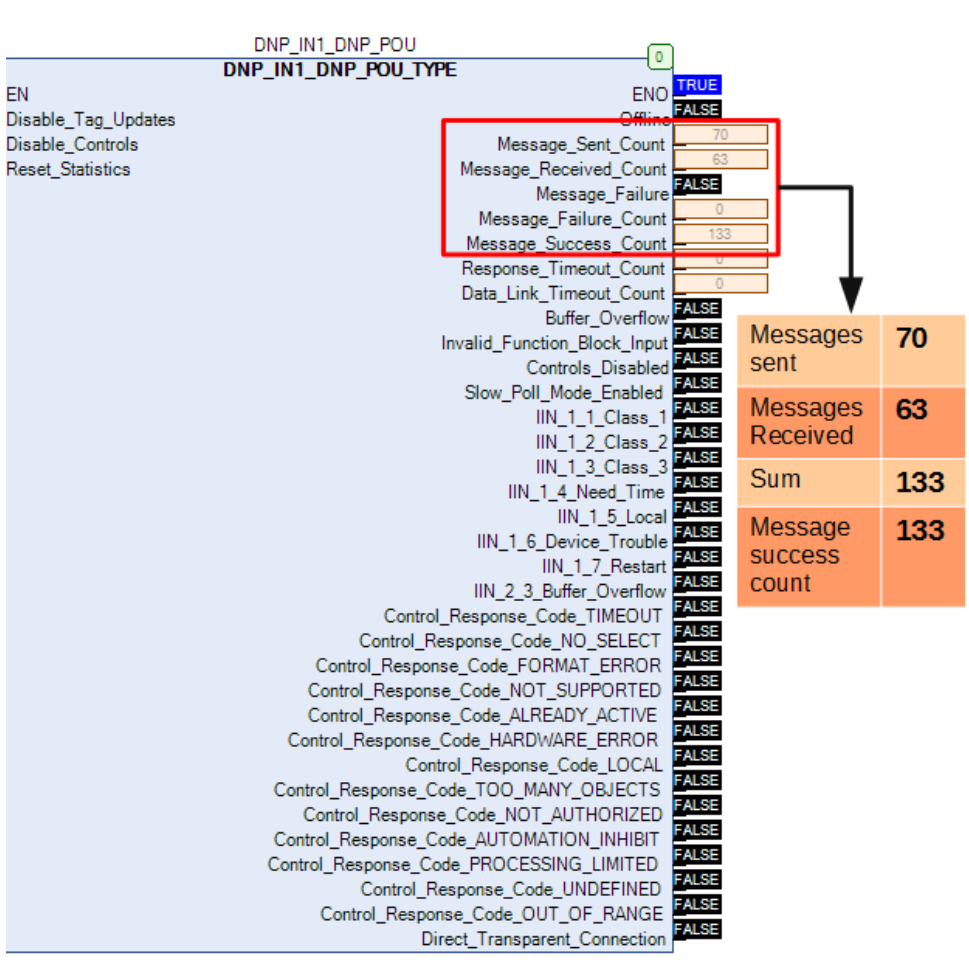
Figure 11. Packets over Wireshark.